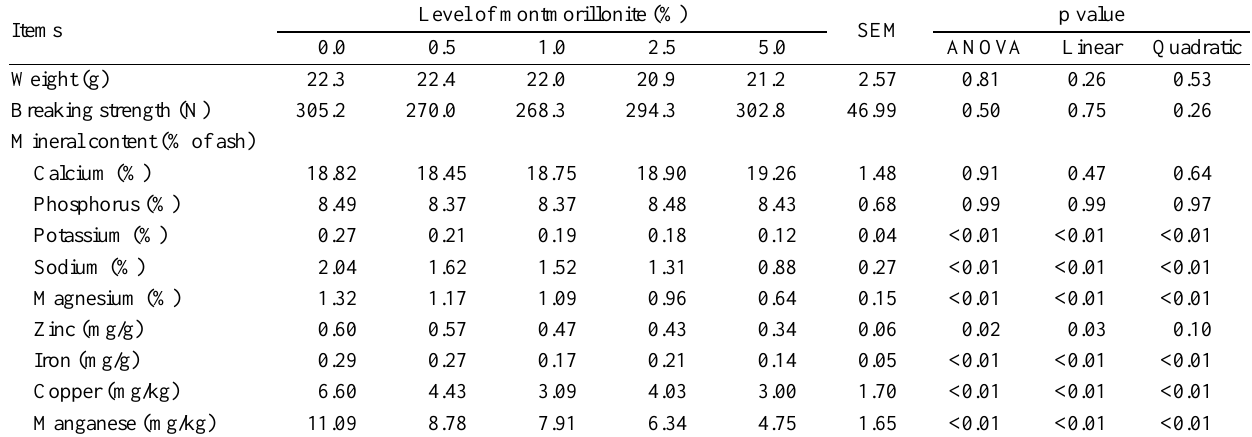
Table 7. C haracteristics of metatarsal bones in weaned pigs fed diets containing graded levels of montmorillonite (d 28) 1 Level of montmorillonite Items